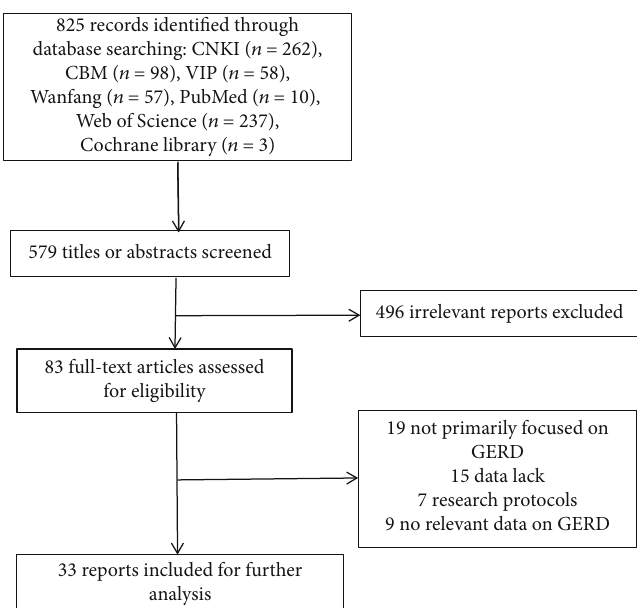
Figure 1: PRISMA fl ow diagram for the selection process for SRs/MAs about Chinese medical treatment for